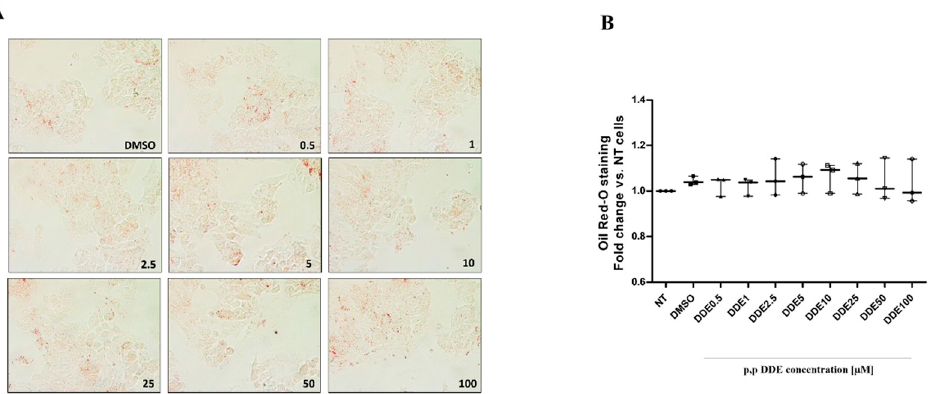
Figure 2. Total lipid content in response to different doses of DDE. Qualitative ( A ) and quantitative ( B ) analyses of total lipid content were performed using Oil-Red O staining. Panel ( A ) showed representative images of lipid droplets accumulated in cells after exposure to DMSO and DDE- doses. Original image magnification used: 40 × . Panel ( B ) showed Oil-Red O quantification measured spectrophotometrically (490 nm). Data were graphically represented as median with range for 3 biological replicates.